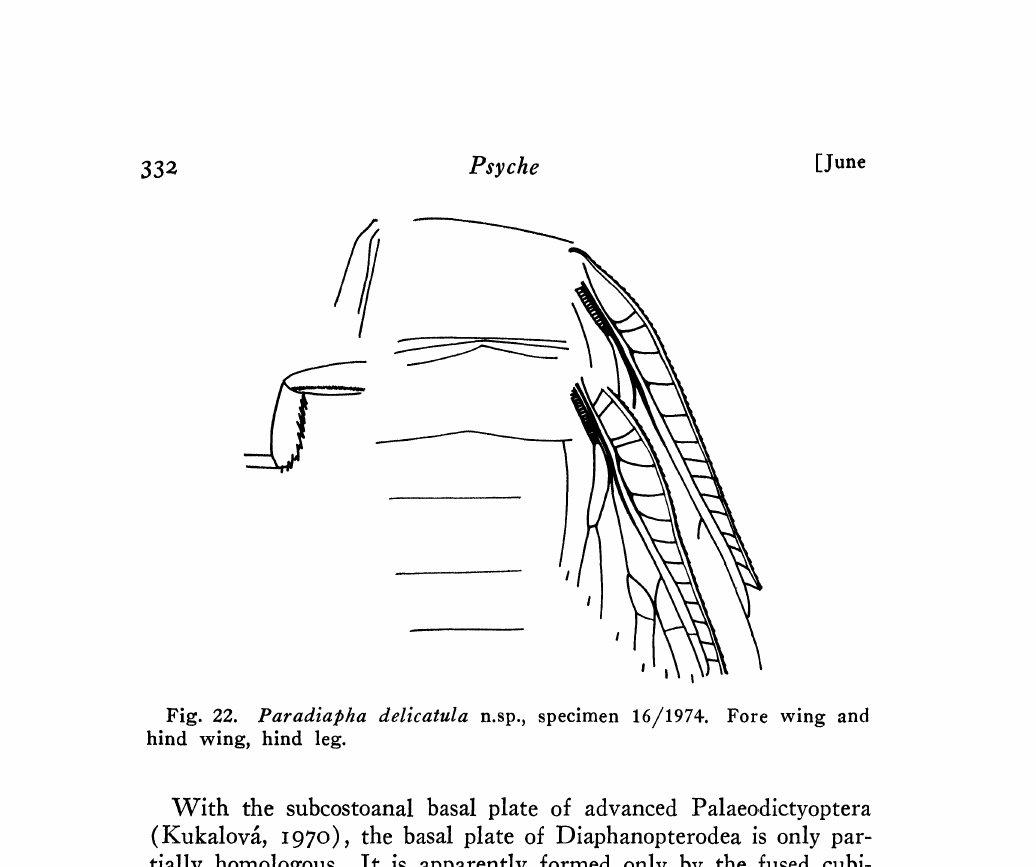
Fig. 22. Paradialha delicatula n.sp., specimen 16/1974. Fore wing and hind wing, hind